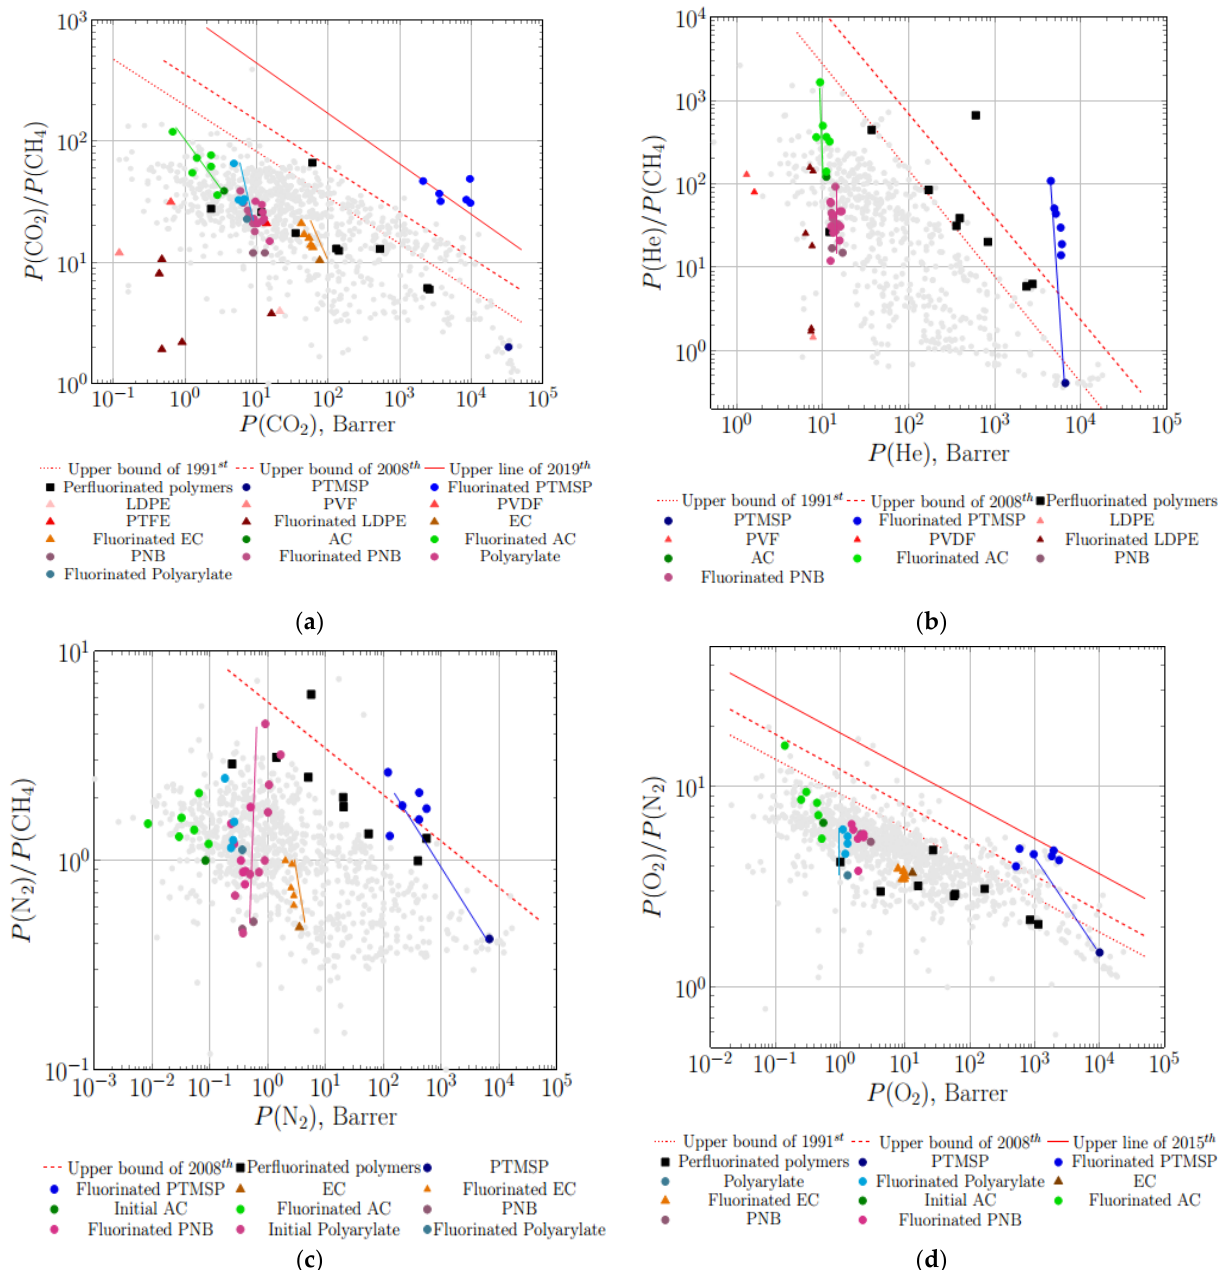
Figure 6. Plots of ideal selectivity vs. permeability coefficient (Robeson diagrams with corresponding upper bounds) for gas pairs CO 2 -CH 4 ( a ), He-CH 4 ( b ), N 2 -CH 4 ( c ) and O 2 -N 2 ( d ) for original and treated with elemental fluorine films, and data for some perfluorinated polymers: perfluorinated polymers [17,31,102–105], virgin and fluorinated PTMSP [58], virgin and fluorinated low density polyethylene (LDPE), polyvinyl fluoride (PVF), polyvinylidene fluoride (PVDF) and polytetrafluoroethylene (PTFE) [44], virgin and fluorinated ethylcellulose (EC) and polyarylate [101], acetyl cellulose (AC) [65].